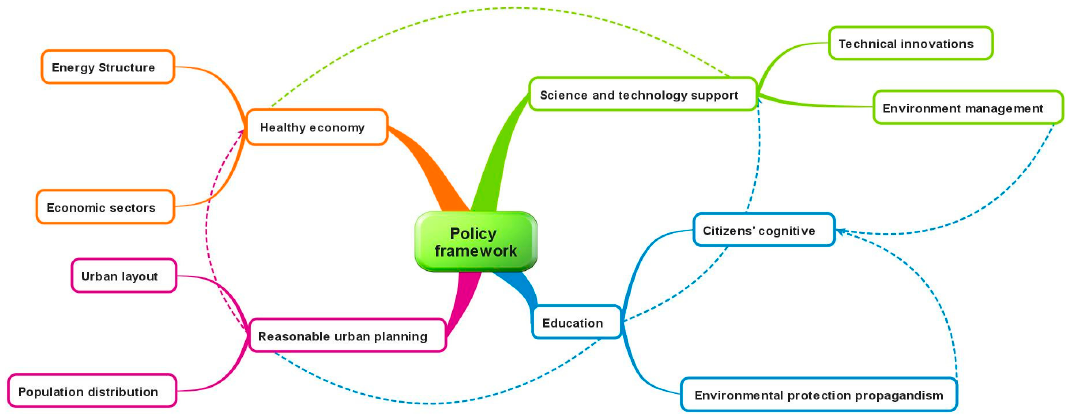
Figure 6. The new mind map of the policy framework.